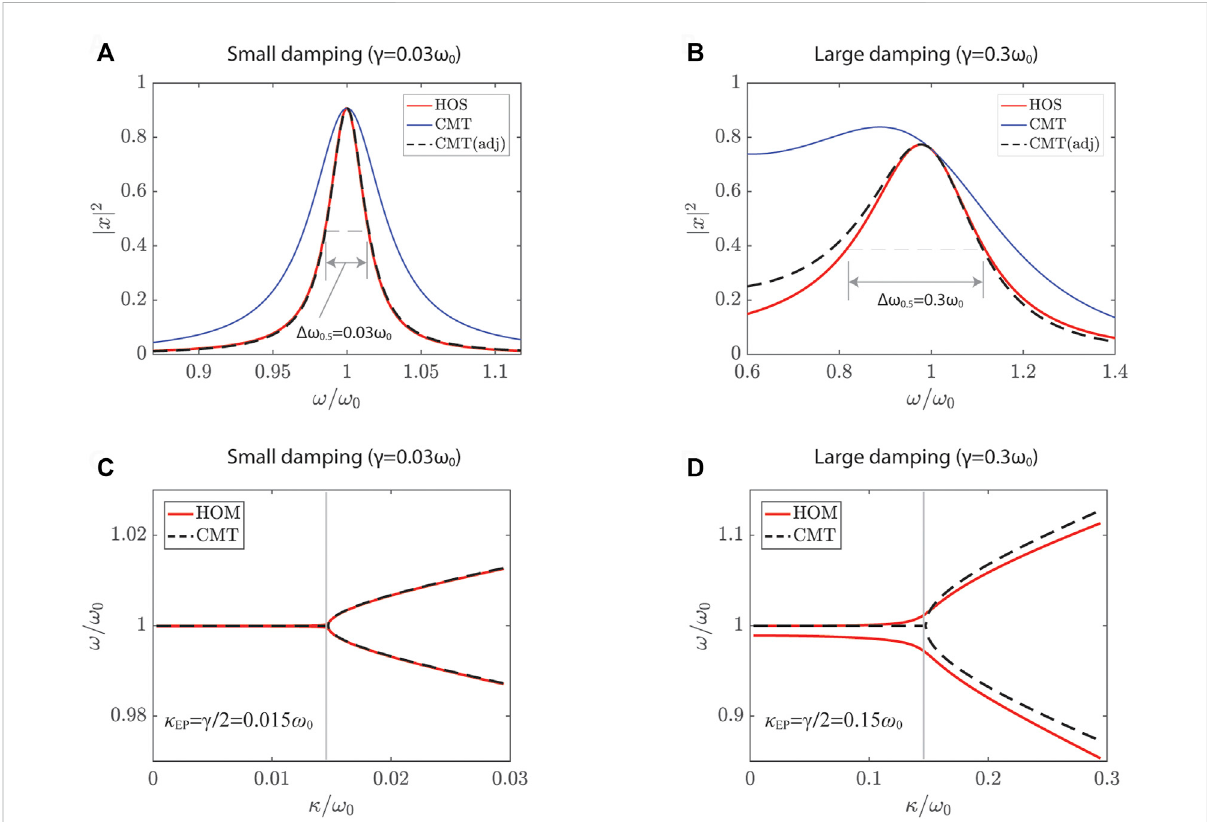
FIGURE 2 Comparison between harmonic oscillator model (HOS) and coupled-mode theory (CMT). (A) Spectral response of a single resonator for small damping( γ =0.03 ω 0 ). (B) Largedamping( γ =0.3 ω 0 ).Eigenfrequenciesofcoupledresonatorsfor γ =0.03 ω 0 (C) and γ =0.3 ω 0 (D) .Produce (A,B) using Eqs. 7, 8 for illustration purpose. Adapt (C,D) from Ref.